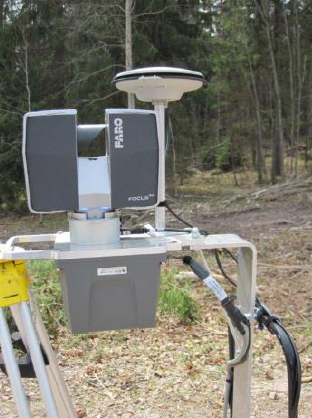
Figure 1. Sensors of the AKHKA R2 system.